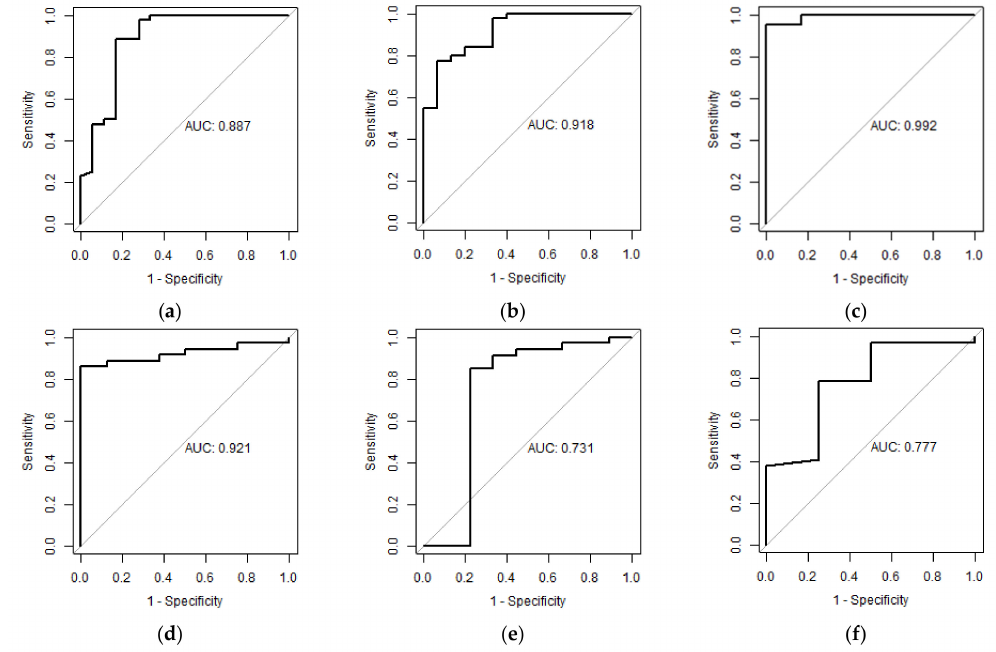
Figure 2. ROC curves showing sensitivity and specificity of IL-6 measurements for good functional outcome: ( a ) IL-6 < 4.5 h; on dismission (cut-off point ≤ 7.11 pg/mL, sensitivity 88.6%, specificity 83.3%), ( b ) IL-6 < 4.5 h; after three months (cut-off point ≤ 6.54 pg/mL, sensitivity 77.3%, specificity 93.3%), ( c ) IL-6 < 4.5 h; after a year (cut-off point ≤ 8.55 pg/mL, sensitivity 95.3%, specificity